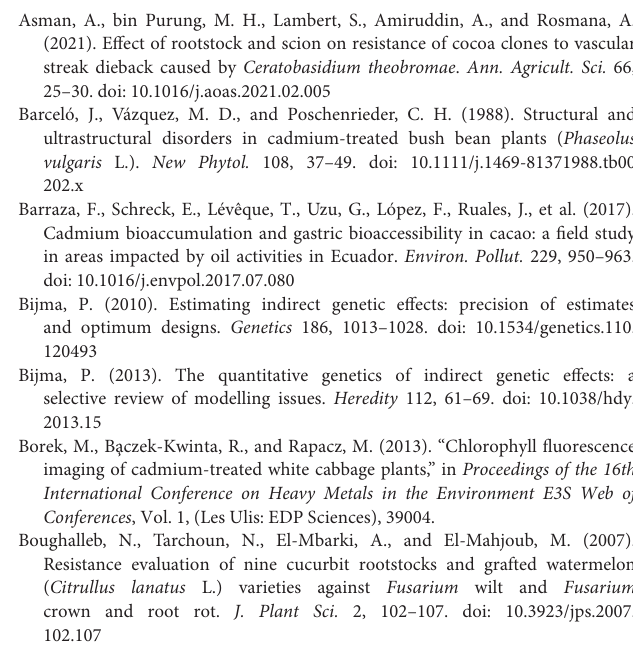
Supplementary Table 5 | Specific combining abilities in cacao seedling rootstocks from controlled crosses two-months after grafting. Estimates were gathered in full-sib rootstock progenies obtained from the crossing between IMC67 × PA121, and its reciprocal cross, grafted with the ICS95 and CCN51 clonal scions under two Cd treatments. Specific combining abilities are indexed to a general mean (intercept under the first column after the p -value), and the corresponding positive or negative contributions (three last columns). Significantly different specific combining abilities are highlighted. Supplementary Table 6 | Specific combining abilities in cacao seedling rootstocks from controlled crosses four-months after grafting. Estimates were gathered in two OP half-sib families (IMC67 and PA121), and two full-sib progenies obtained from the crossing between IMC67 × PA121 and its reciprocal cross, grafted with the ICS95 and CCN51 clonal scions under two Cd treatments. Specific combining abilities are indexed to a general mean (intercept under the first column after the p -value), and the corresponding positive or negative contributions (three last columns). Significantly different specific combining abilities are highlighted. Supplementary Table 7 | Narrow-sense rootstock-mediated heritability (h2) in cacao seedling rootstocks from controlled-crosses two-months after grafting. Estimates were gathered in two OP half-sib families (IMC67 and PA121), and two full-sib progenies obtained from the crossing between IMC67 × PA121 and its reciprocal cross, grafted with the ICS95 and CCN51 clonal scions under two Cd treatments. Heritability ( h 2 ) and model fits ( r ) estimates were computed using an A pedigree relatedness matrix ( Supplementary Figure 2B ) inputted in a “genetic prediction” additive mixed linear model, according to de los Campos et al. (2009). Heritability ( h 2 ) scores above 0.1 are highlighted. Supplementary Table 8 | Narrow-sense rootstock-mediated heritability (h2) in cacao seedling rootstocks from controlled-crosses four-months after grafting. Estimates were gathered in two OP half-sib families (IMC67 and PA121), and two full-sib progenies obtained from the crossing between IMC67 × PA121 and its reciprocal cross, grafted with the ICS95 and CCN51 clonal scions under two Cd treatments. Heritability ( h 2 ) and model fits ( r ) estimates were computed using an A pedigree relatedness matrix ( Supplementary Figure 2C ) inputted in a “genetic prediction” additive mixed linear model, according to de los Campos et al. (2009). None h 2 estimate was above